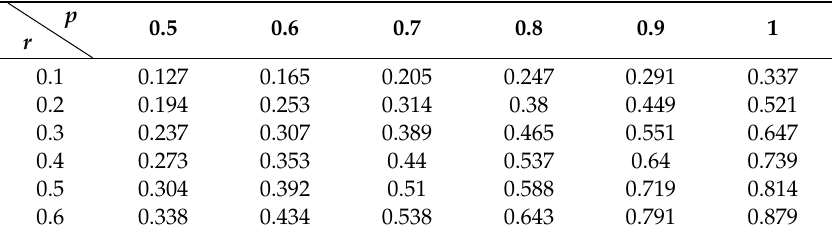
Table 3. S ba ( µ m) for di ff erent values of p (mm 2 / tooth) and r ( /